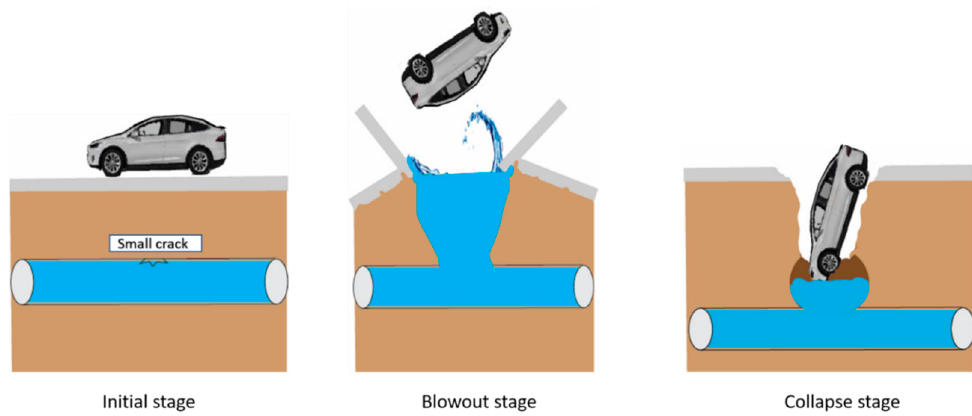
Figure 1. Various stages of watermain related soil failures.